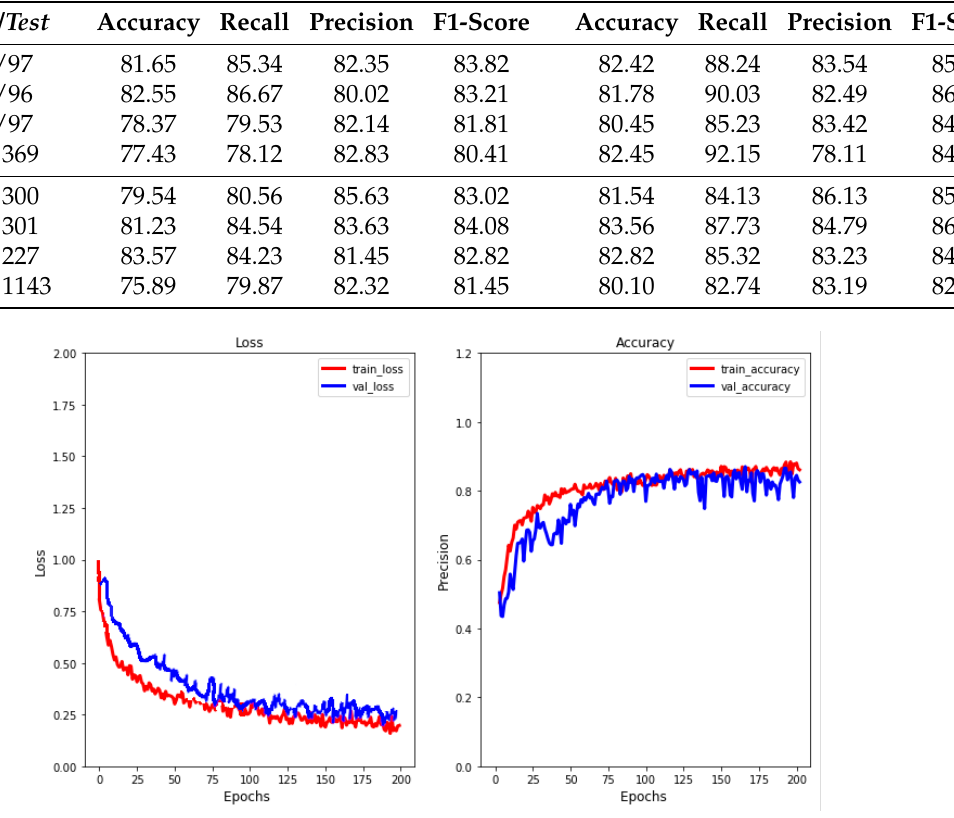
Figure 14. ( left ) Loss as a function of the epochs. ( right ) accuracy reported by the model as a function of the